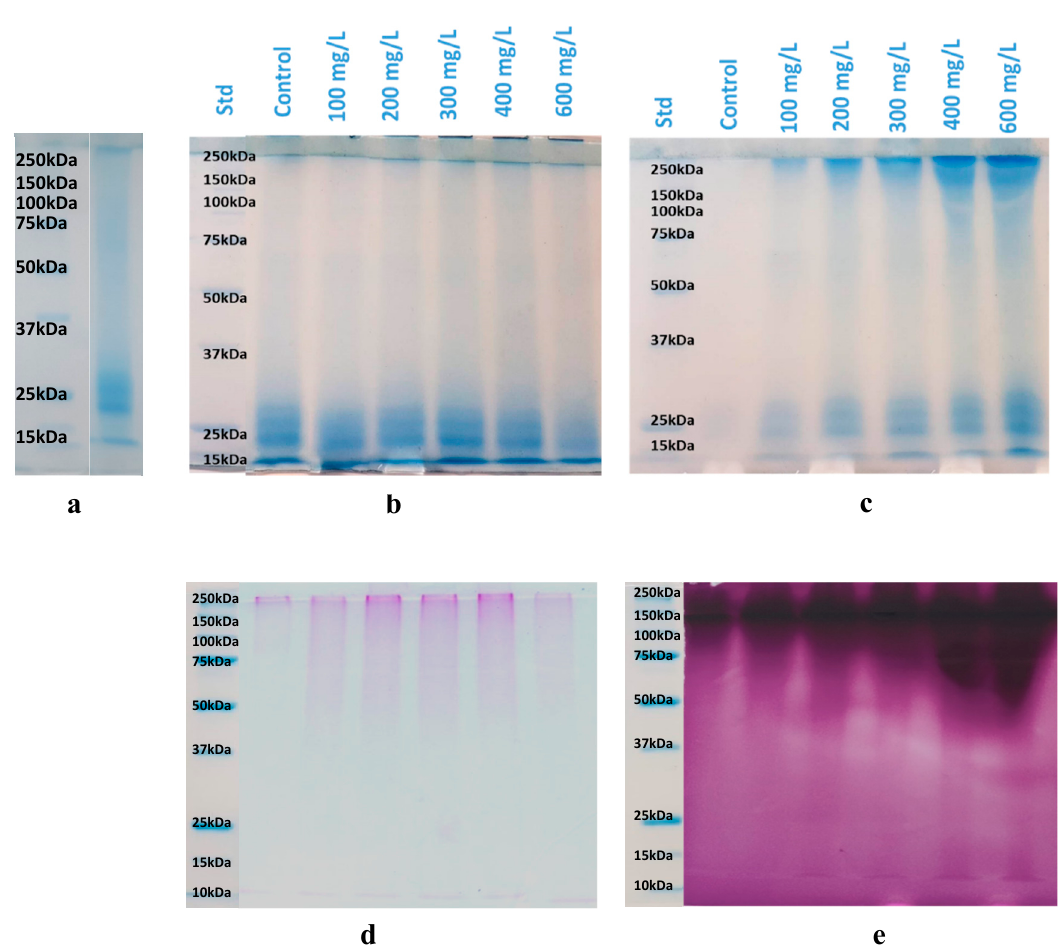
Figure 4. SDS-PAGE electrophoresis of Vernaccia wine proteins before the heat stability test ( a ) and of the two fractions, haze (HF) ( b – d ) and supernatant (SF) ( c – e ), obtained after centrifugation of the wines added with increasing amount (mg / L) of freeze-dried polysaccharides (UFS) and heat treated. Control: Vernaccia wine with no UFS addition. The proteins were stained on the electrophoretic gel with Bio safe Coomassie ( b,c ) and with Schiff’s reagent ( d,e ). Std: Blue precision plus molecular weight standards.